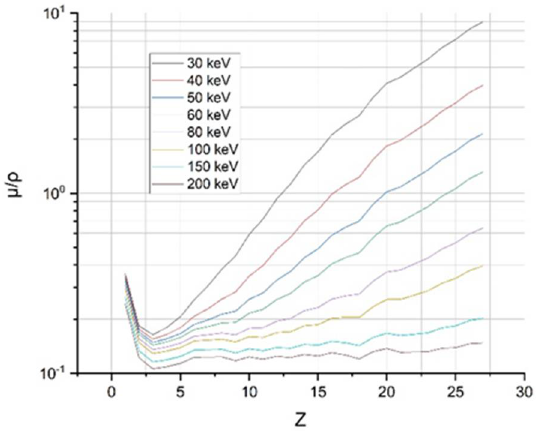
Figure 4. Mass attenuation coefficient µ / ρ (cm 2 /g) as a function of the Z of the first 26 elements for several energies.